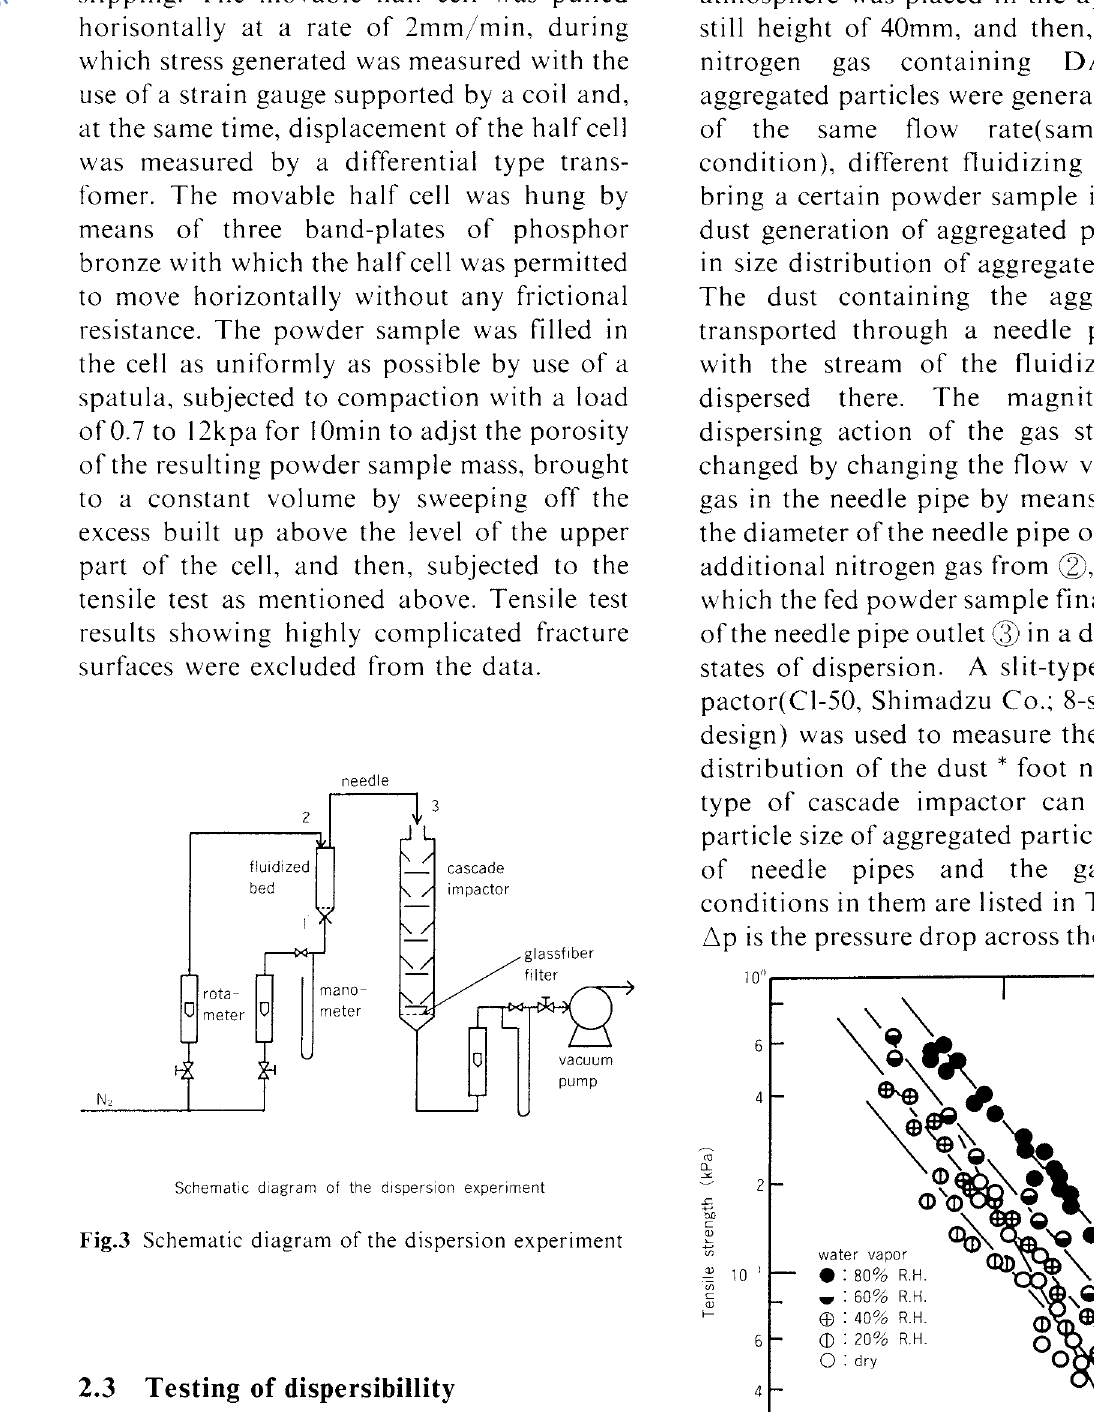
Fig.3 Schematic diagram of the dispersion experiment